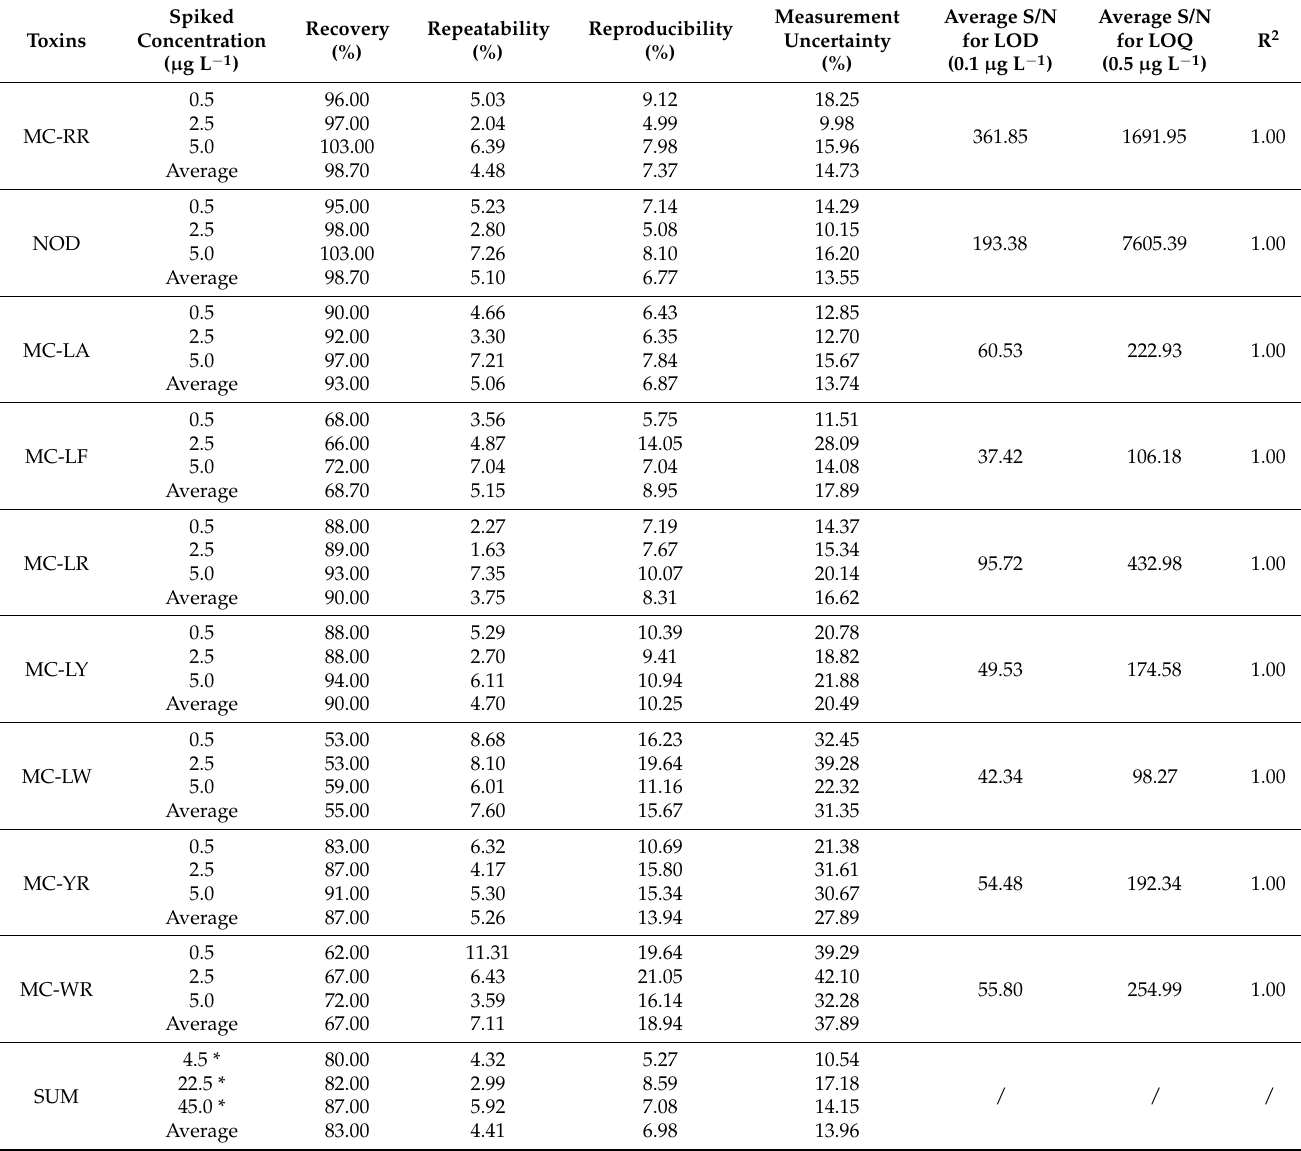
Table 2. Overview of validation results for eight microcystin congeners (MC), nodularin (NOD) and the sum of all toxins in water. Results for the recovery, repeatability, reproducibility, measure- ment uncertainty, R 2 and average signal to noise (S/N) for the limit of detection (LOD) and the limit of quantification (LOQ) are shown on average and at three concentration levels. * µ g L − 1 total microcystin.